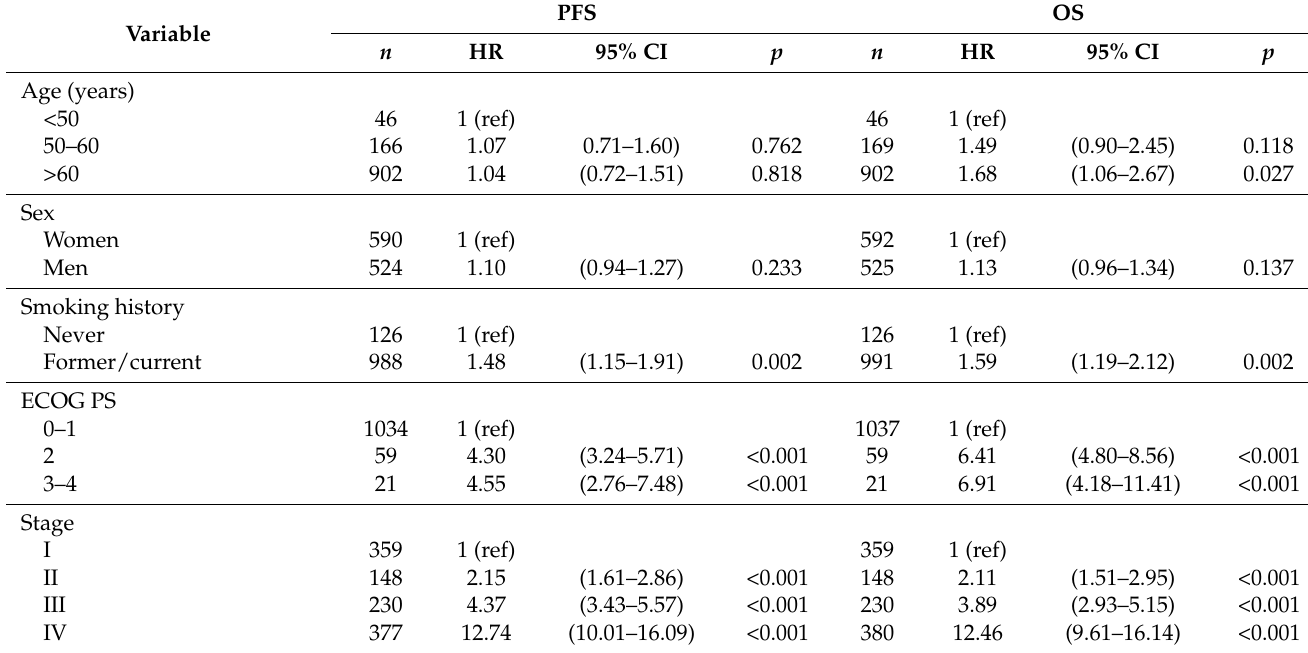
Table 2. Univariable analyses (Cox proportional hazards model) of patient and clinical characteristics and their associations with PFS and OS in the whole